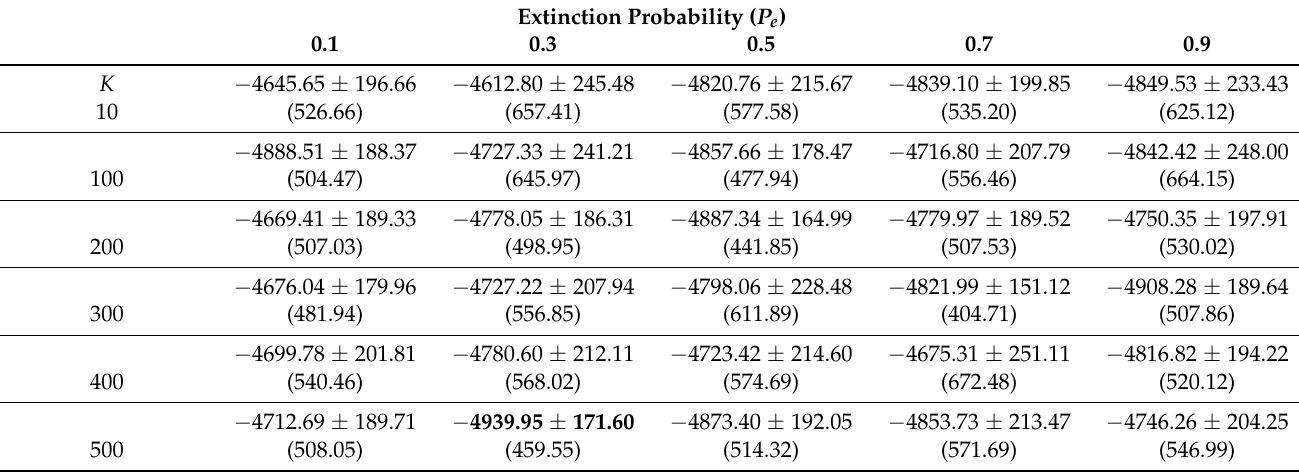
Table 7. Fitness results of SDEP with targeted extinction on Schwefel ( K is the stagnant counter and fitness threshold T = 0.5); 95% confidence interval is presented after ± sign, and standard deviation is presented inside parenthesis. Minimum results are in bold